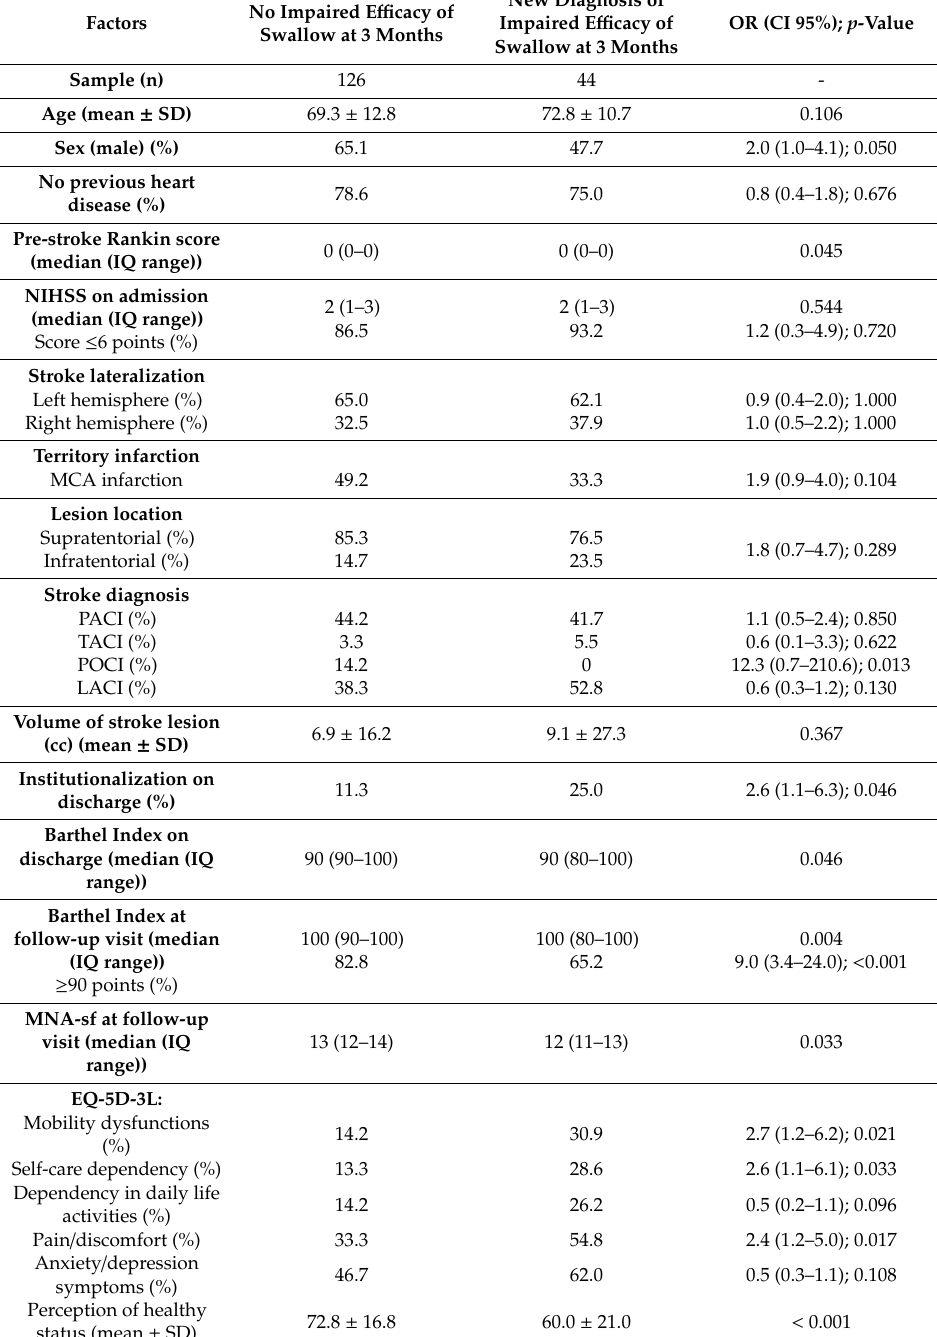
Table 4. Factors significantly associated with worsened e ffi cacy of swallowing at 3 months